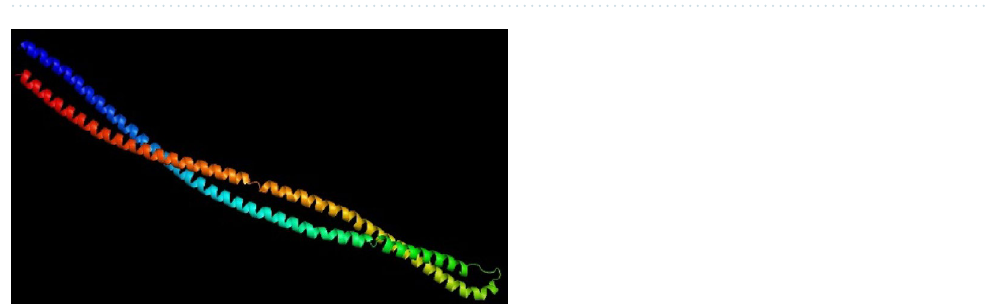
Figure 2. The PSIPRED server predicted a graphical demonstration of secondary structure properties of the final designed vaccine. Our vaccine’s protein sequence comprised 60% alpha-helices, 39% beta strands, and 0.4% coils.